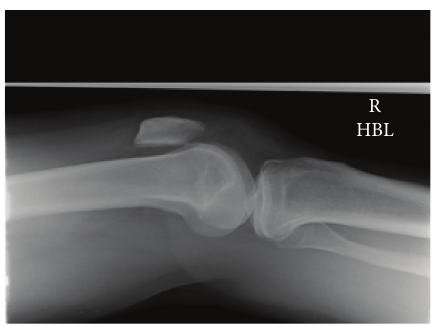
Figure 1: Lateral radiographs of right knee.